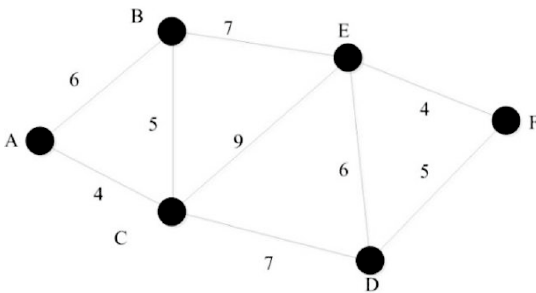
Figure 1 Schematic diagram of local shortest